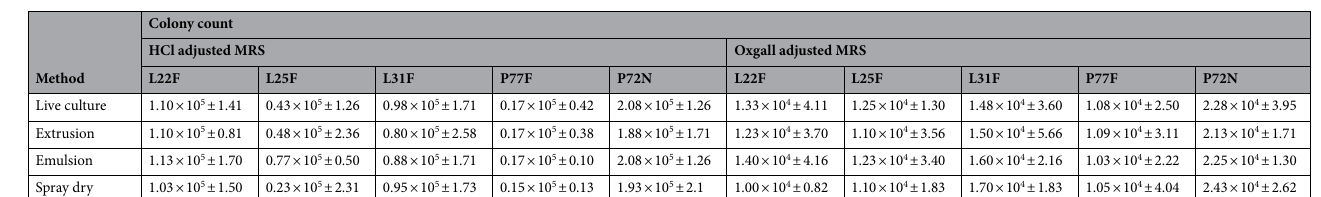
Table 2. Viable colony count of live-cultures and 6-month stored encapsulated LAB after acid-bile incubation. Colony counts ≥ 10 4 CFU/mL indicate tolerance to acid and bile.